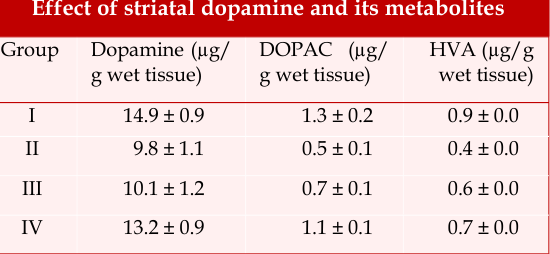
Effect of striatal dopamine and its